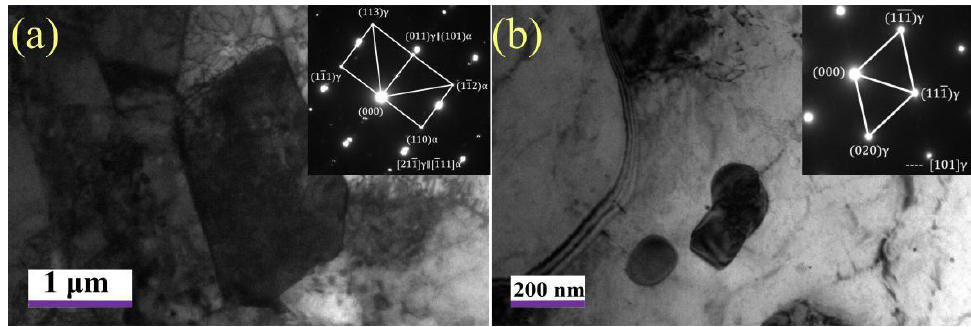
Figure 7. TEM micrographs of MA constituents tempered at 550 °C ( a ) and 650 °C ( b ).